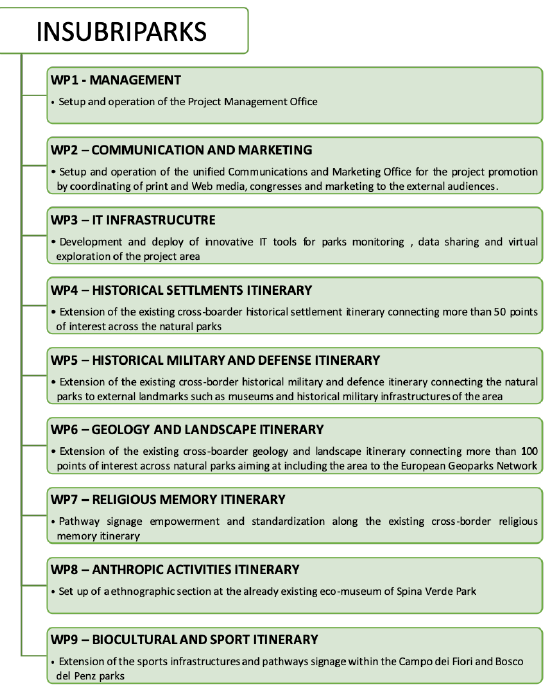
Figure 3. Schematic of the INSUBRIPARKS project work breakdown structure